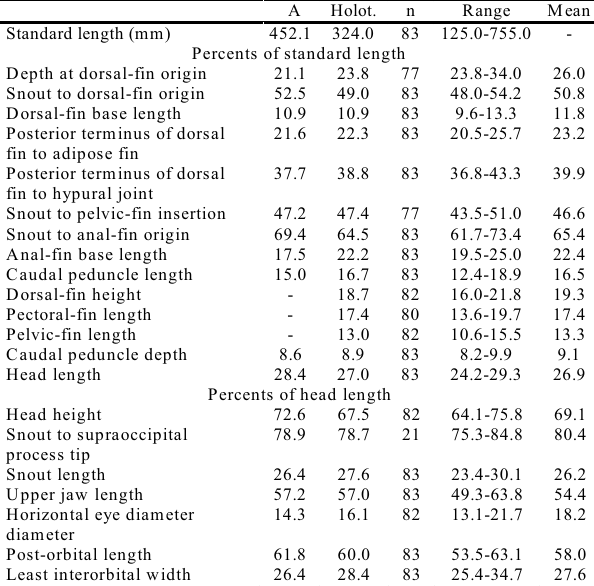
Table 1. Morphometric data of Salminus franciscanus . A: MNHN A. 8556 (stuffed specimen, its data not included in the range or